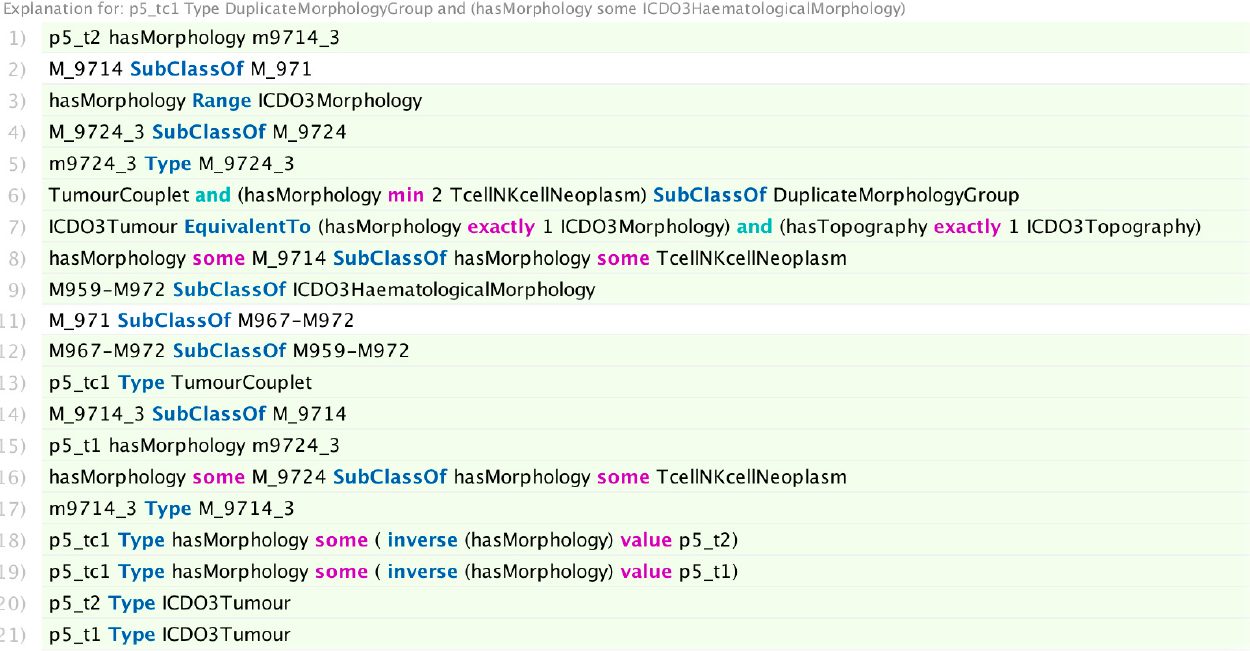
Figure 13. DL query for tumour couplets with haematological morphologies in a common group. The reasoner has found one such case–p5_tc1, with the explanation provided in Figure 14.